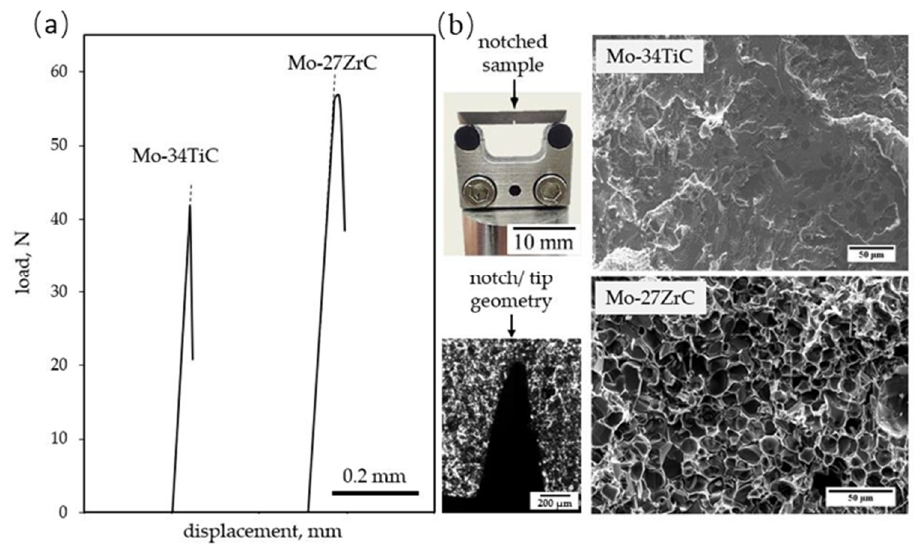
Figure 3. ( a ) Representative load-displacement curves of Mo-TiC/ZrC composites obtained by three- point bending test at room temperature perpendicular to growth direction; ( b ) fracture surfaces after cracking.